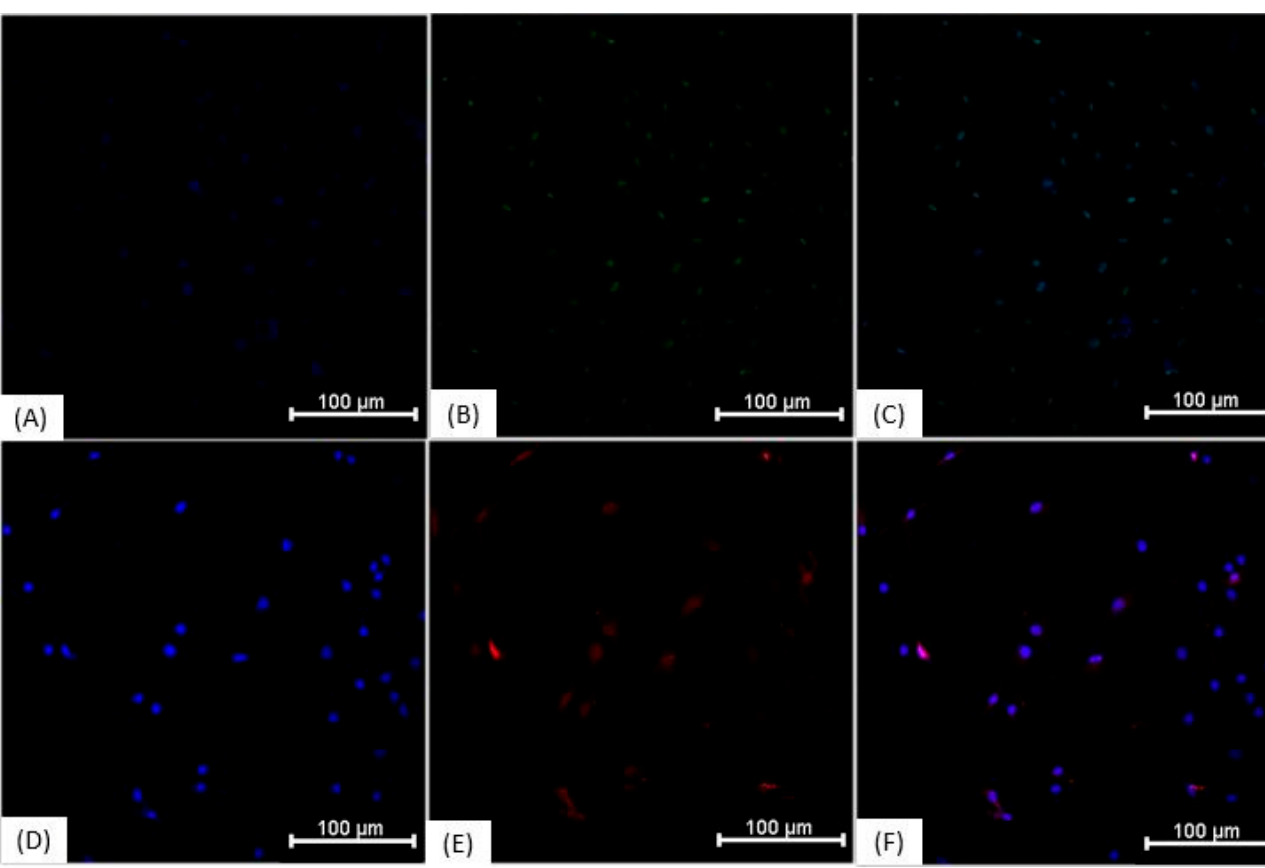
Figure 5. Immunocytochemistry of ADMSCs on polystyrene culture plate. ( A ) ADMSCs grown on polystyrene culture plate marking the nucleus with Hoechst (blue); ( B ) Anti-AMOT antibody with nuclear localization (FITC—green); ( C ) Overlapping images A and B; ( D ) ADMSCs grown on polystyrene culture plate marking the nucleus with Hoechst (blue); ( E ) Anti-YAP1 antibody with nuclear localization (Cy5—red); ( F ) Overlapping images D and E. The images were taken with In Cell Analyzer 2000, GE (20×). Scale bars, 100 µm. ADMSCs, adipose-derived mesenchymal stem cells.